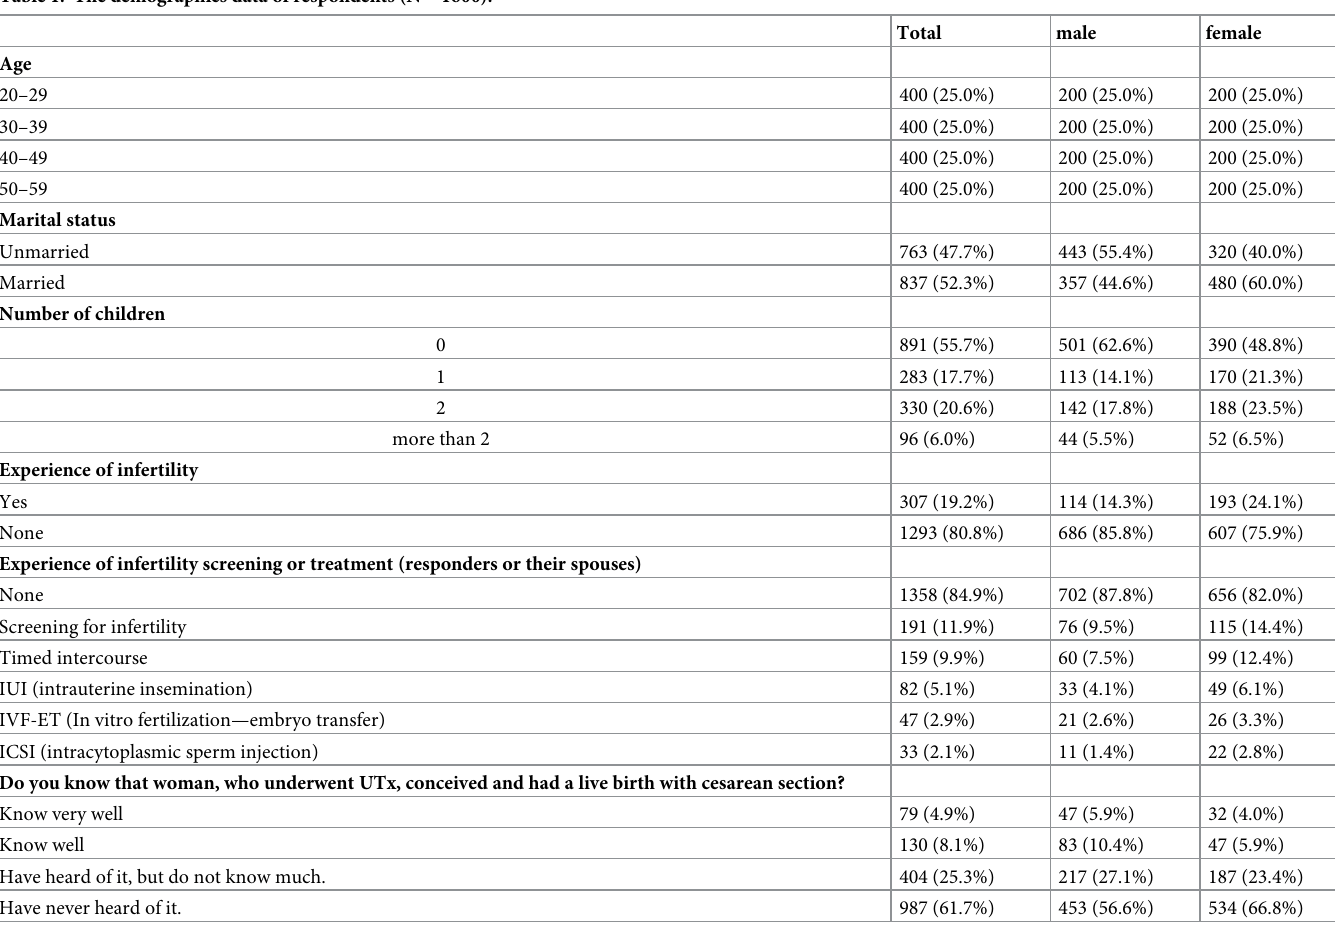
Table 1. The demographics data of respondents (N =